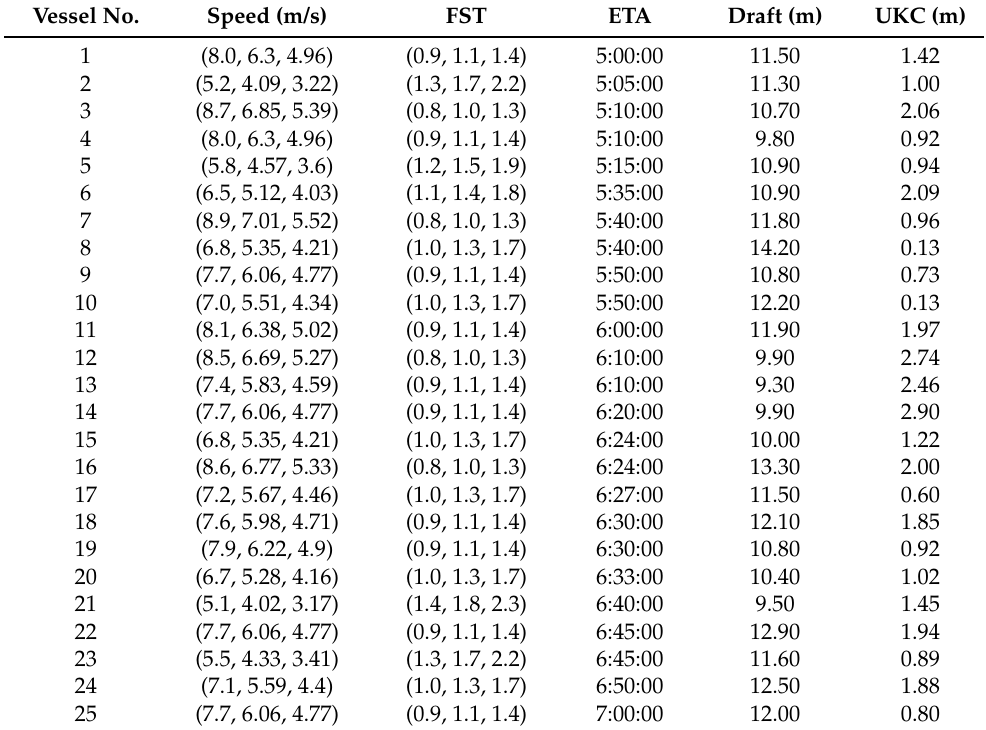
Table 2. Vessel static application information.